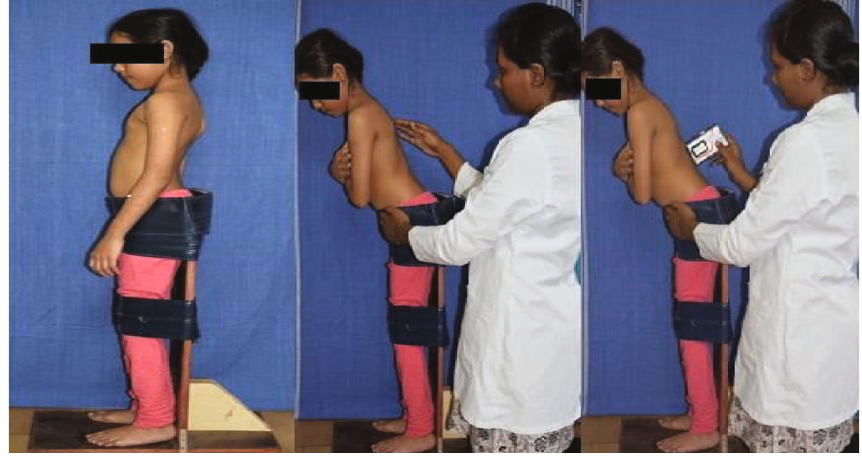
Figure 1: Measurement of trunk position sense. Table 1: Demographic data of the participants of the study ( n = 24